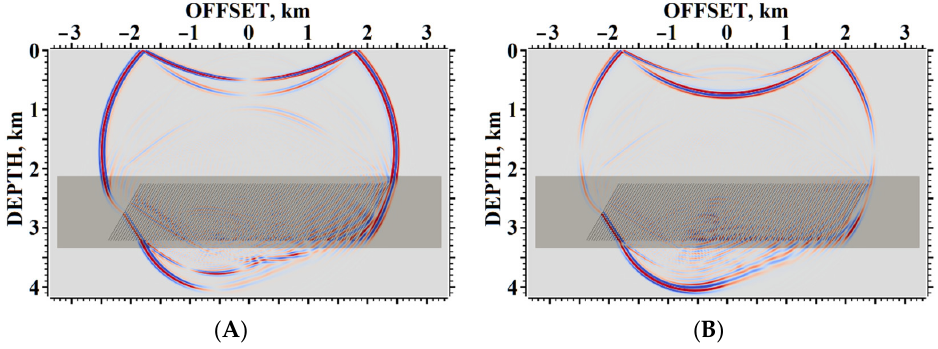
Figure 28. Example #3, snapshots at the time moment of 0.86 s: ( A ) horizontal component of velocity; ( B ) vertical component of velocity.